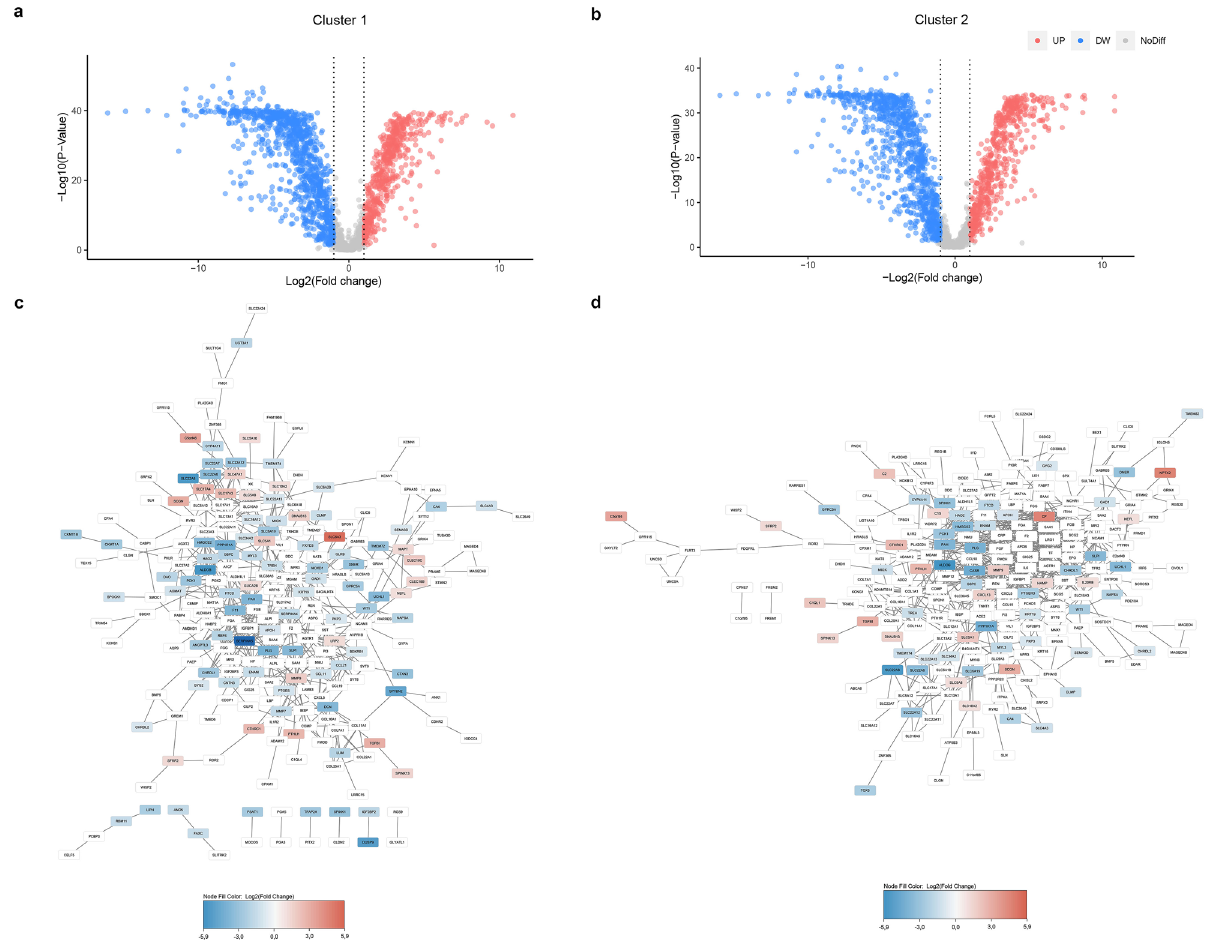
Figure 2. Identification of marker genes for Cluster 1 and Cluster 2 ( a ) using the rank sum test. Scheme of PPI taking into account changes in gene expression ( b ). Volcano plot of DEGs for Cluster 1 ( a ); volcano plot of DEGs for Cluster 2 ( b ). The dotted line shows the twofold change in expression clipping; red shows an increase in expression, blue a decrease in gene expression; PPI for Cluster 1 ( c ); PPI for Cluster 2 ( d ); the gradient from blue to red shows the change from lower to higher gene expression in